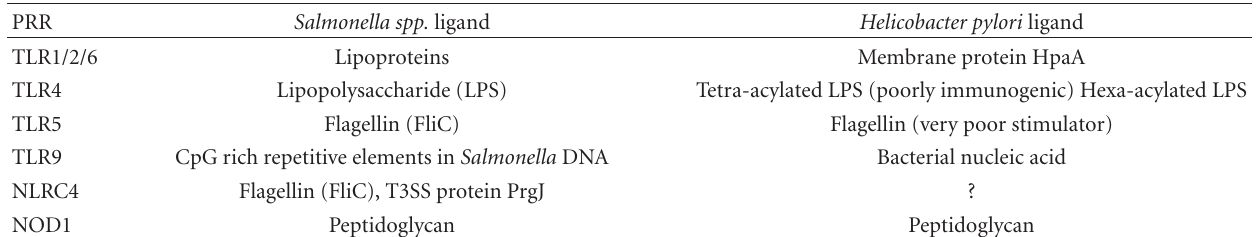
Table 1: Pattern recognition receptor activating ligands from Salmonella spp. and Helicobacter pylori.